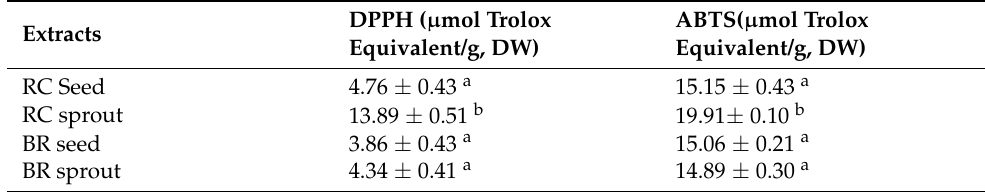
Table 2. Antioxidant activity ( µ mol Trolox equivalent/g,